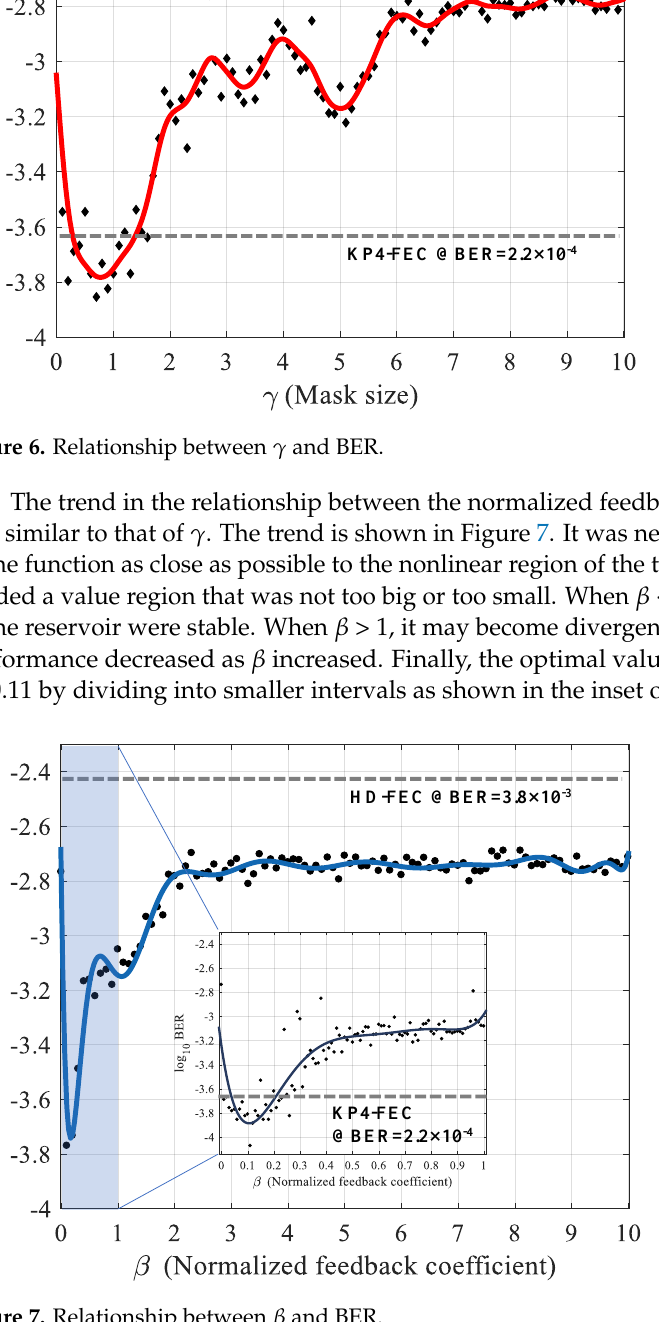
Figure 7. Relationship between β and BER.